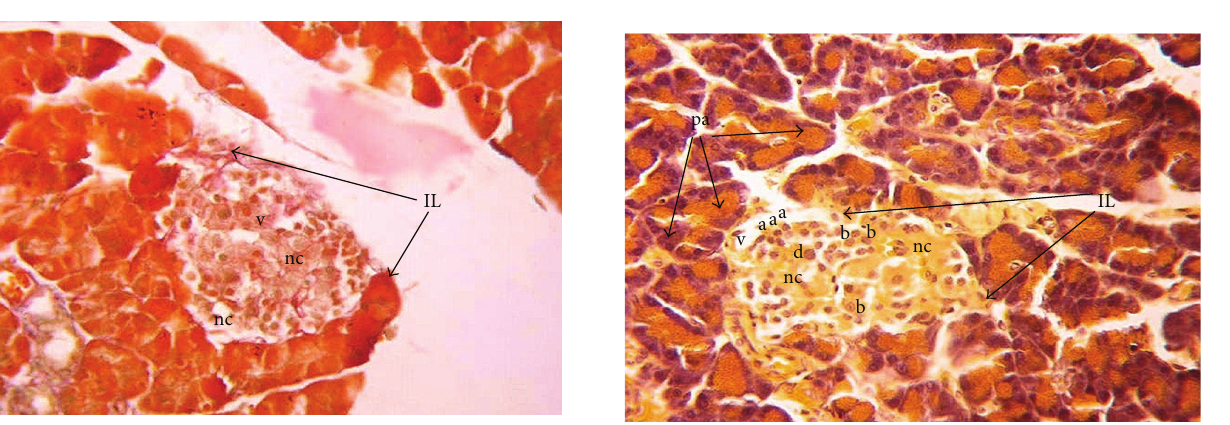
Figure 6: Photomicrograph of pancreas section of diabetic rat offspring after two weeks of birth showing severe degenerative changes. Many necrotic foci (nc) vacuolations (v) are noticed in the islets (IL); the number of beta-cells (b) is reduced and the hypertrophied ones are degenerating. Alpha-cells, delta-cells, and pancreatic acini (pa) are indicated by symbols a, d, and pa, respectively, ( × 400).